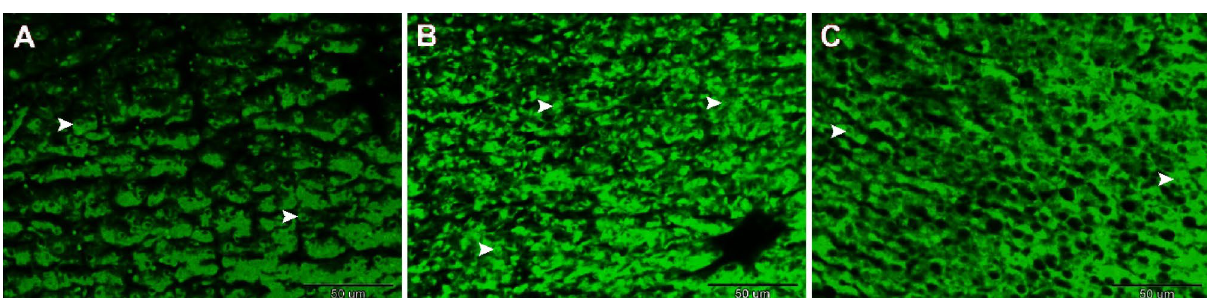
Figure 5. Fluorescence photomicrograph of paraffin-embedded sections illustrating the hepatoprotective effects of NSS against 4-NP-induced hepatic damage in Clarias gariepinus . ( A ) Hepatocytes of the control group’s liver have healthy nuclei (arrowheads). ( B ) Numerous hepatocytes are visible in the liver of the 4-NP-intoxicated group containing necrotic and broken nuclei (arrowheads) C: The NSS + 4-NP-treated group’s liver contains hepatocytes with healthy nuclei (arrowheads). The necrotic nuclei (DNA) stained with acridine orange appeared as orange spots under a fluorescence microscope. Scale bar = 50 μm, acridine orange